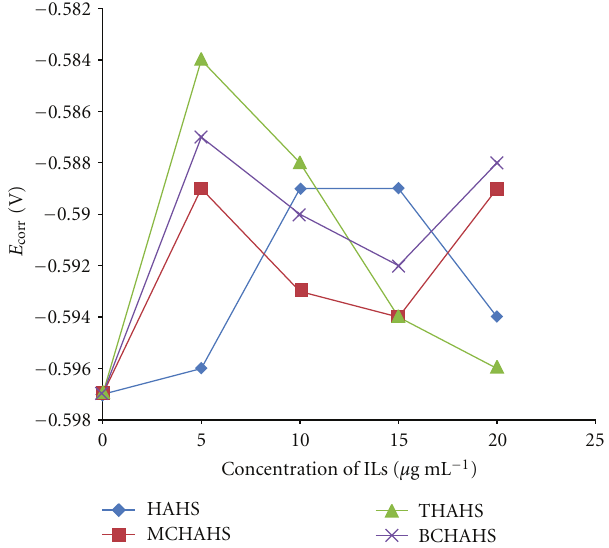
Figure 6: E ff ect of di ff erent ILs and their concentrations on the corrosion potential of Pb-Sb-Sn alloy. Conditions: Scan rate, 5.0mVs − 1 ; H 2 SO 4 4.0 mol · L − 1 ; Immersion time, 5